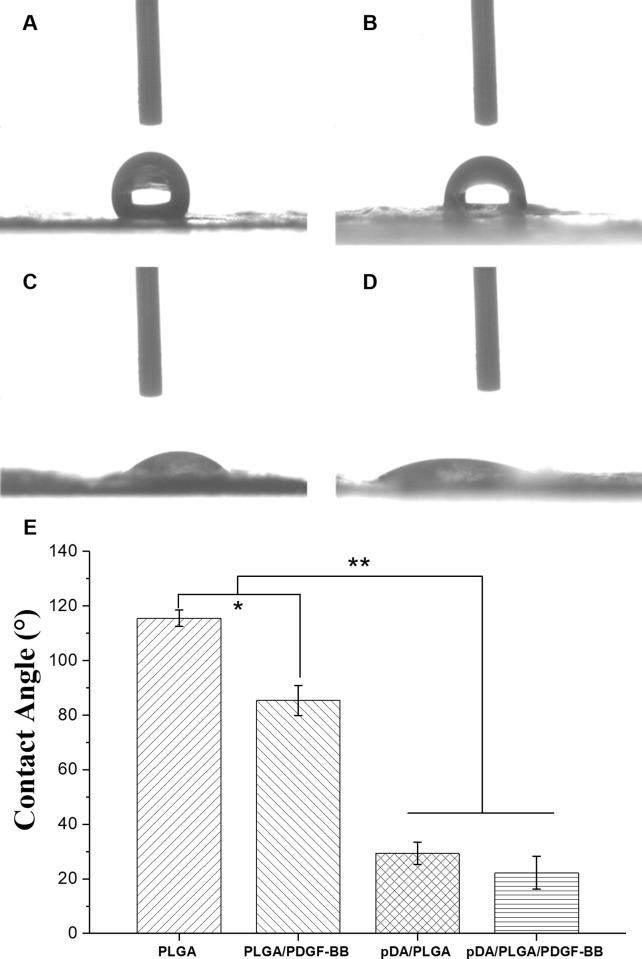
The hydrophilia performance of the PLGA fiber substrates. (A) PLGA, (B) PLGA/PDGF-BB, (C) pDA/PLGA (D) pDA/PLGA/PDGF-BB. (E) Average water contact angle analysis. *p<0.05, **p<0.01.